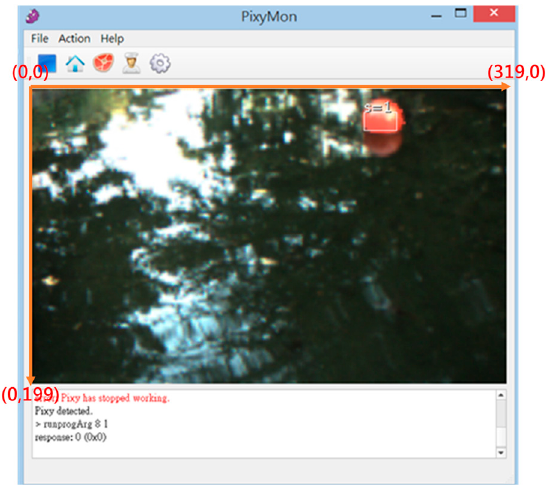
Figure 13. X and Y coordinates of the image extracted by the vision sensor.